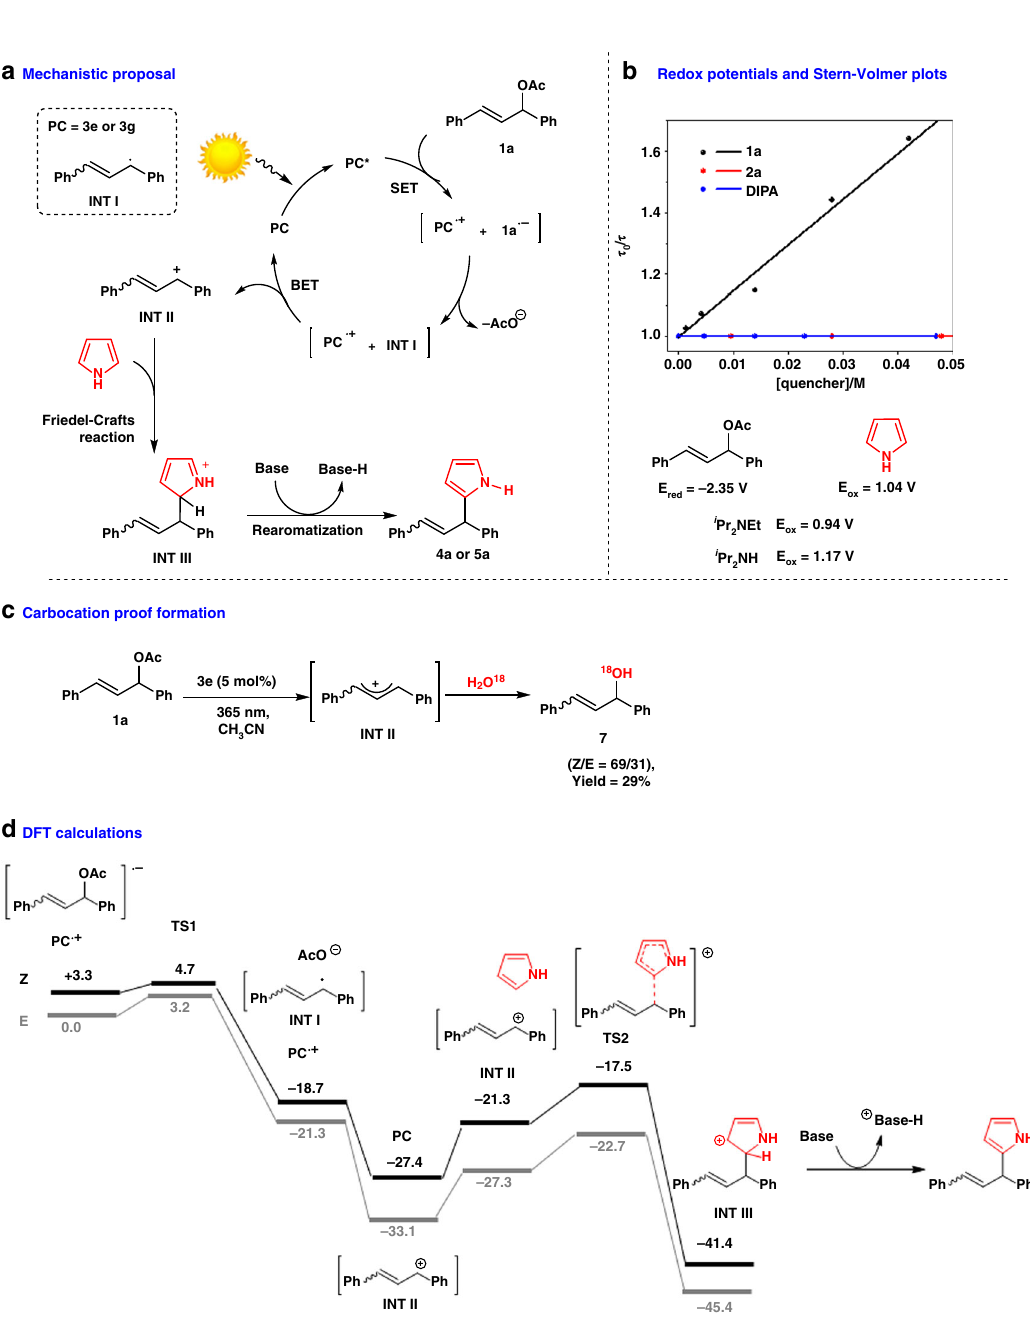
Fig. 3 Mechanistic studies. a Mechanistic proposal for the photoallylation. b Redox potentials and Stern – Volmer plots of the time-resolved fl uorescence quenching of 3g with 1a , pyrrole, and DIPA (DIPA = diisopropylamine). c Reaction of 1a with H 2 O 18 under standard reaction conditions. d For DFT calculations, geometry optimizations were performed using the M06-2X functional in combination with the 6-311G** basis set